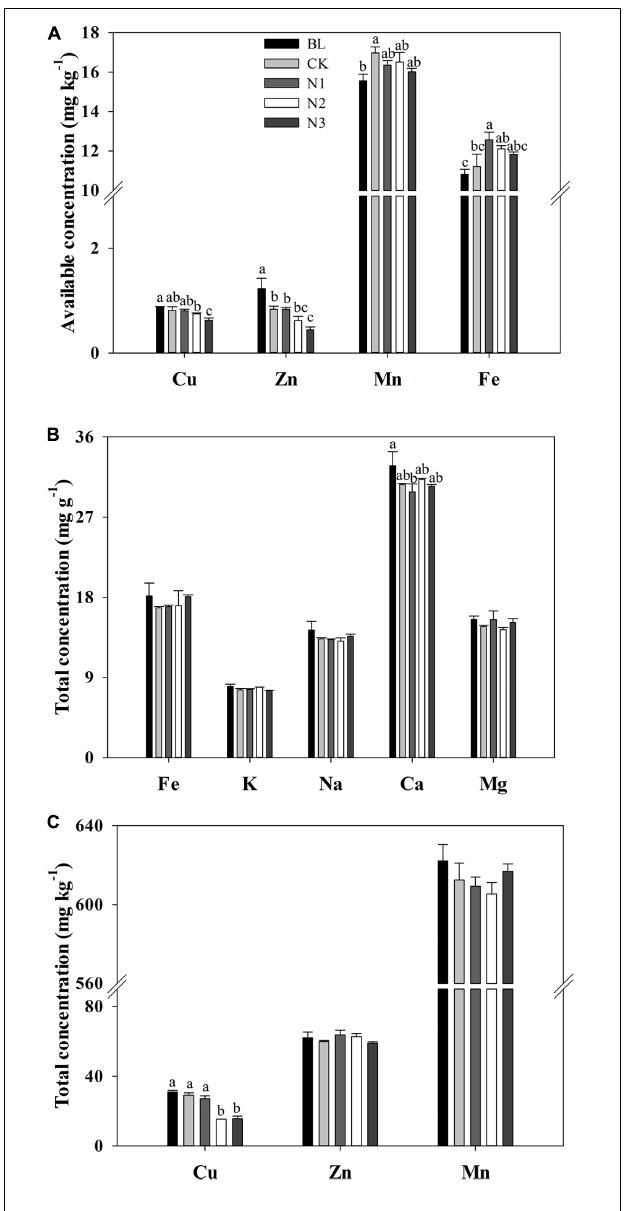
FIGURE 1 | Effects of N addition on macro- and micronutrient concentrations in the soils of B. ischaemum . (A) The available concentrations of Cu, Zn, Mn, and Fe in soils of B. ischaemum . (B) The total concentrations of Fe, K, Na, Ca, and Mg in soils of B. ischaemum . (C) The total concentrations of Cu, Zn, and Mn in soils of B. ischaemum . Error bars are SE ( n = 3). Different letters above bars indicate a significant difference at P =